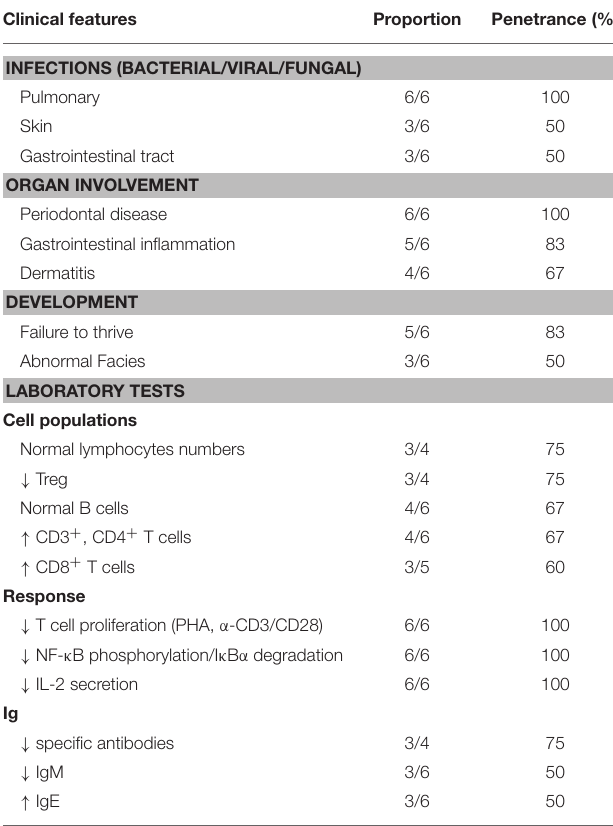
TABLE 8 | “Red flags” suggestive of human MALT1